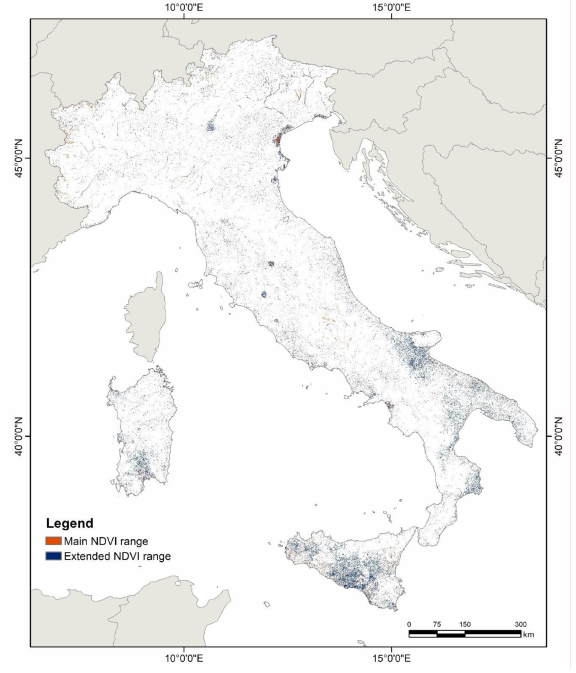
Figure 8. Raster of the possible land consumption produced by the third